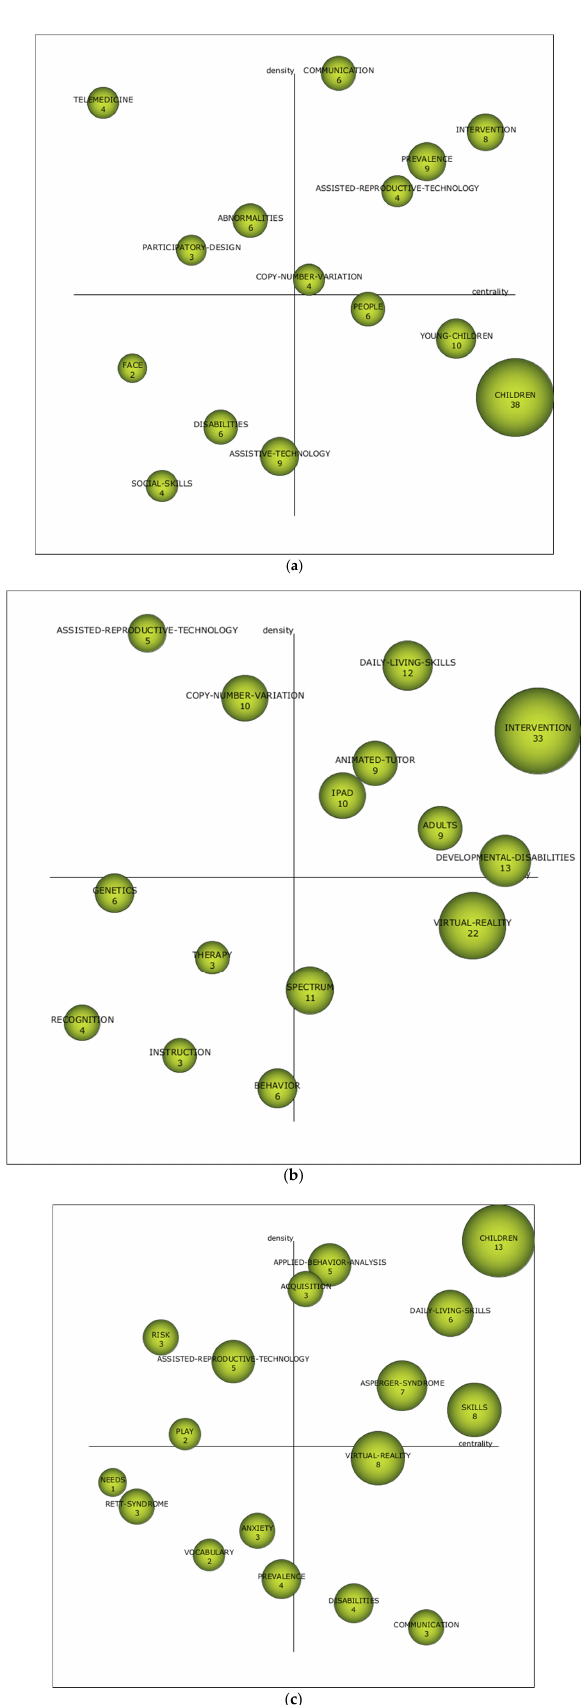
Figure 4. ASD-TECH strategic diagram by h-index. ( a ) 1992–2012; ( b ) 2013–2016; ( c )